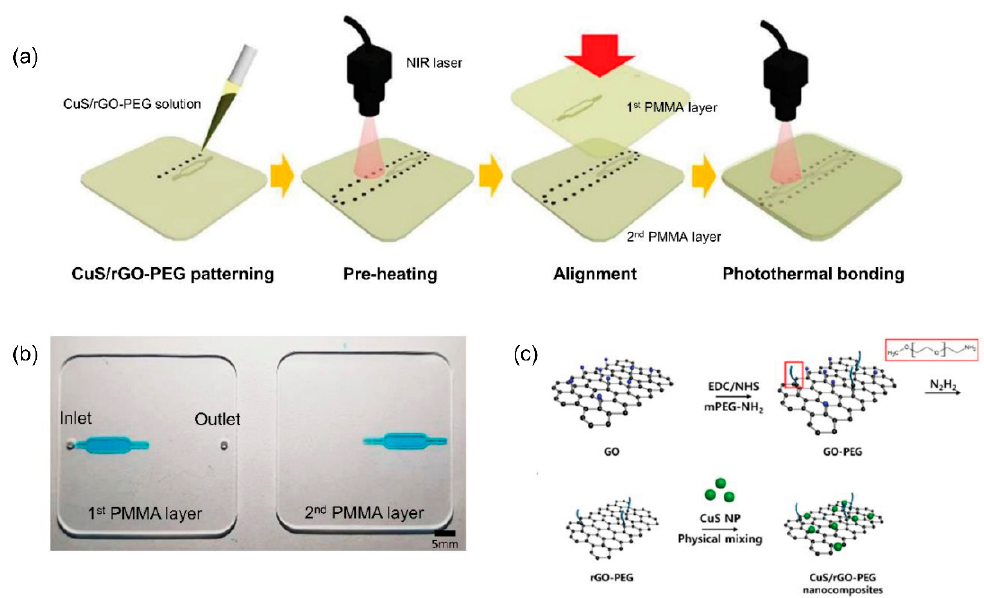
Figure 5. ( a ) Schematics showing PMMA bonding process using CuS/rGO ‐ PEG nanocomposite and the photothermal effect. ( b ) Photographs of the PMMA device. ( c ) The synthesis process of the CuS/rGO ‐ PEG nanocomposite [99]. Table 1. Comparison of bonding methods for thermoplastic devices.